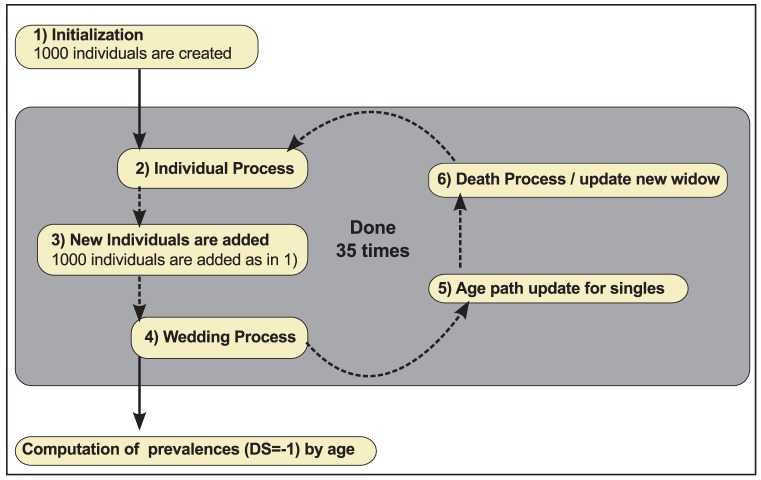
Formal algorithm at population level.1) An artificial population of 1000 individuals is initialized. 2) The Individual process is run for each individual. 3) New individuals are added. 4) Individuals are married. 5) The Age path of singles is updated. 6) Individuals die and their corresponding new widows are created. For one simulation, steps 2–6 are performed 35 times. At the end of the simulation, the prevalences of depressed individuals are computed by age.